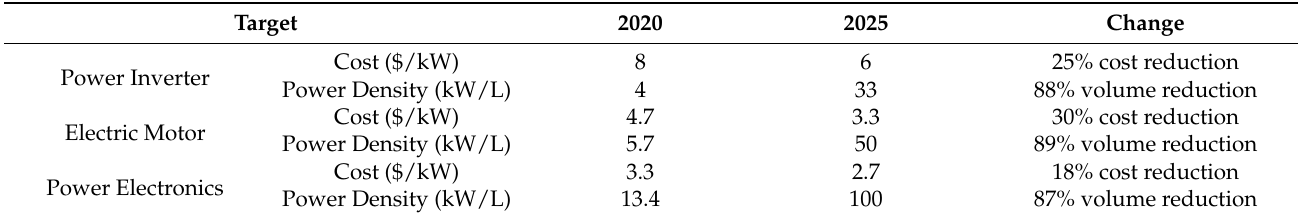
Table 7. U.S Department of Energy (DOE) targets for electric drive